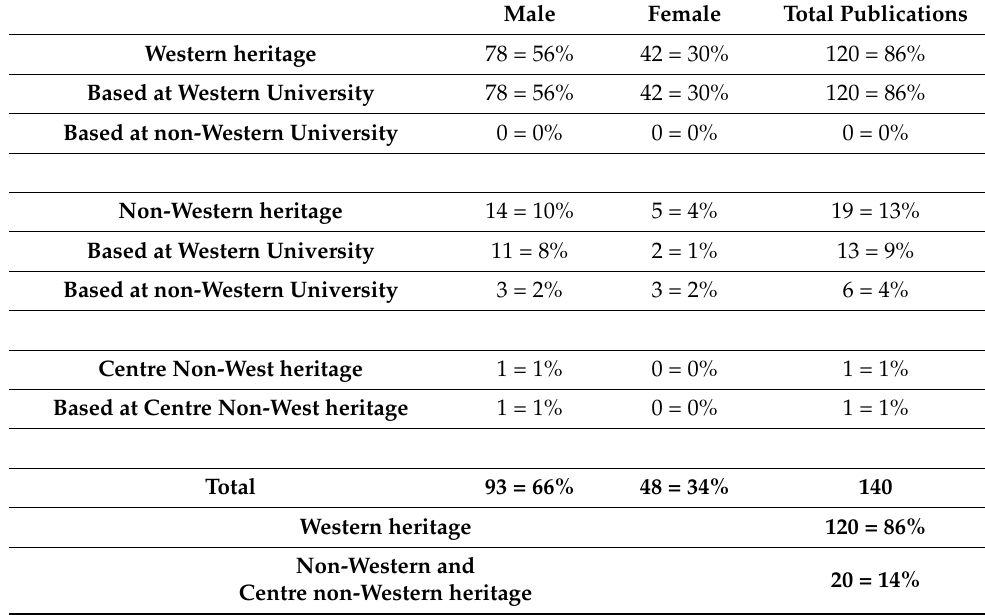
Table A3. Behavioural sciences of terrorism and political